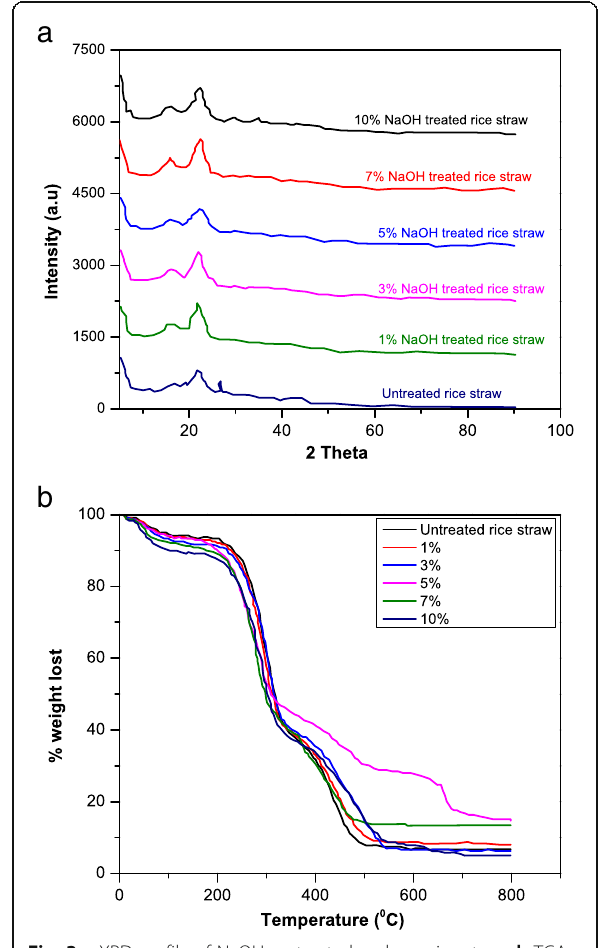
Fig. 3 a XRD profile of NaOH pretreated and raw rice straw. b